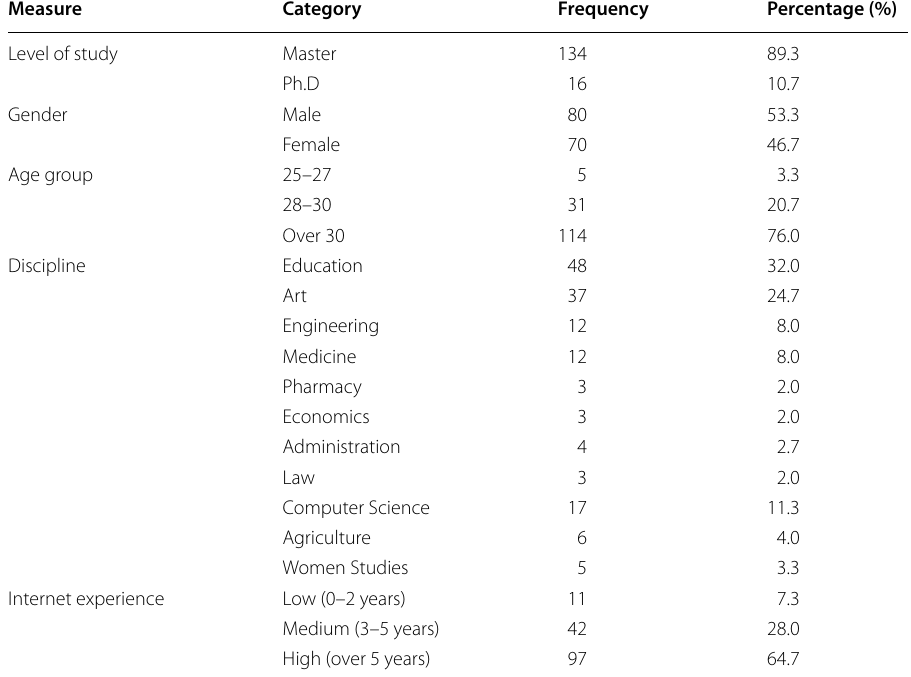
Table 1 Demographics characteristics Measure